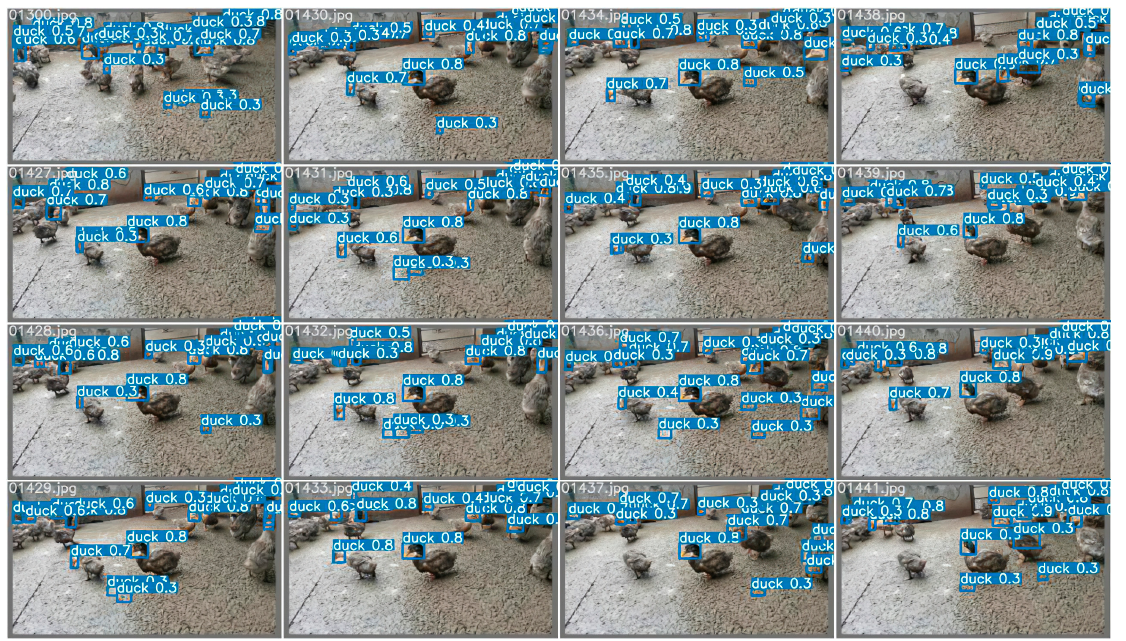
Figure 17. The effect of scheme three. The locations, masking conditions, and individual behaviors of the ducks vary in each extracted frame. The single-head dataset of the ducks improves duck detection success and sex-estimation